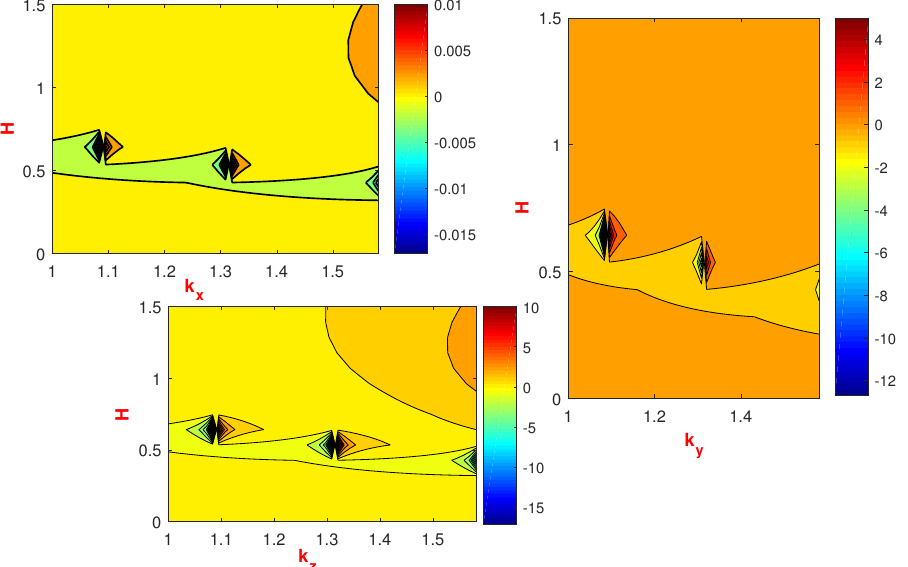
Figure 5. Contour plot of the dispersive coefficient component P xx . The variation is shown with respect to the quantum diffraction parameter H and wave vectors ( k x , k y and k z ).